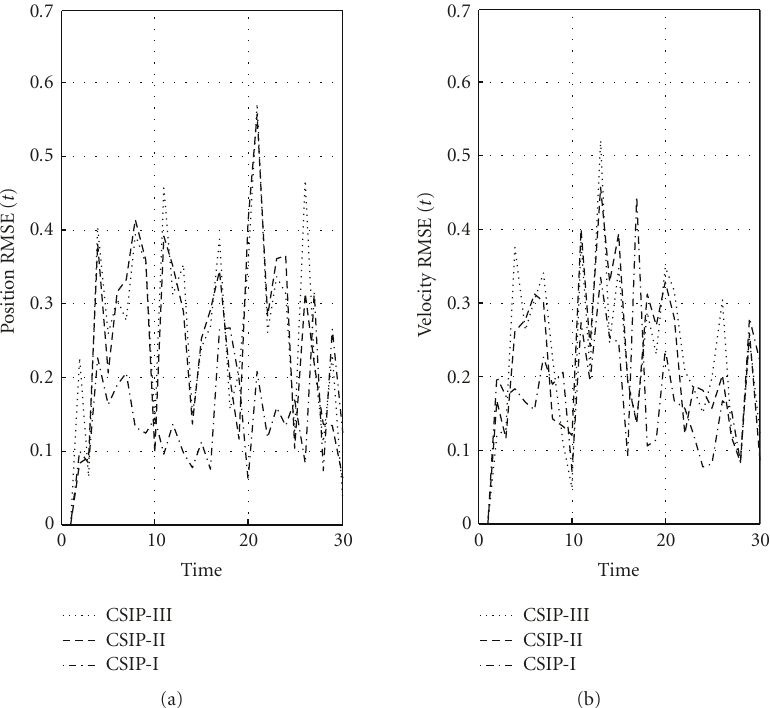
Figure 5: The position RMSE and velocity RMSE under 100 Monte Carlo simulations. x -axis unit: second; y -axis unit for left subplot: meter; y -axis unit for right subplot: meter per